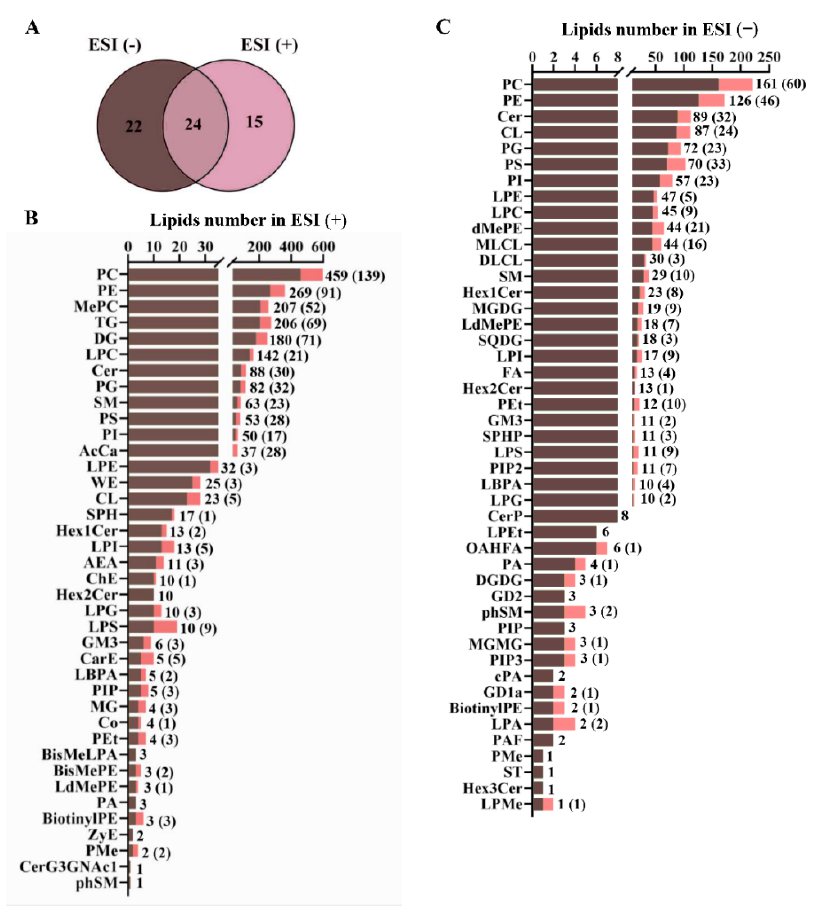
Figure 4. Correlation analysis of quality control (QC) samples in positive ion modes ( A ) and nega- tive ion modes ( B ), respectively, by UPLC/QEMS-based lipidomics. Totally, 46 and 39 subclasses of lipids in live were detected in electron spray ioniza- tion positive and negative modes, i.e., ESI (+) and ESI ( − ), respectively, including 24 joint subclasses between them (Figure 5A). More details were shown in Figure 5B and Figure